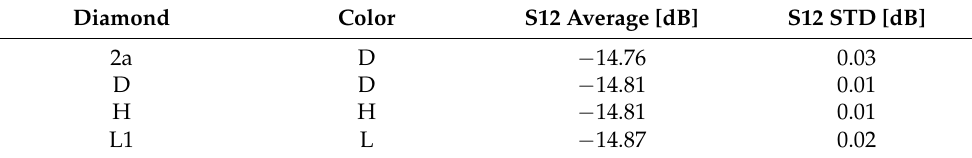
Table 4. Average and STD of S12 at a frequency of 7.175 GHz for the master diamonds. Diamond